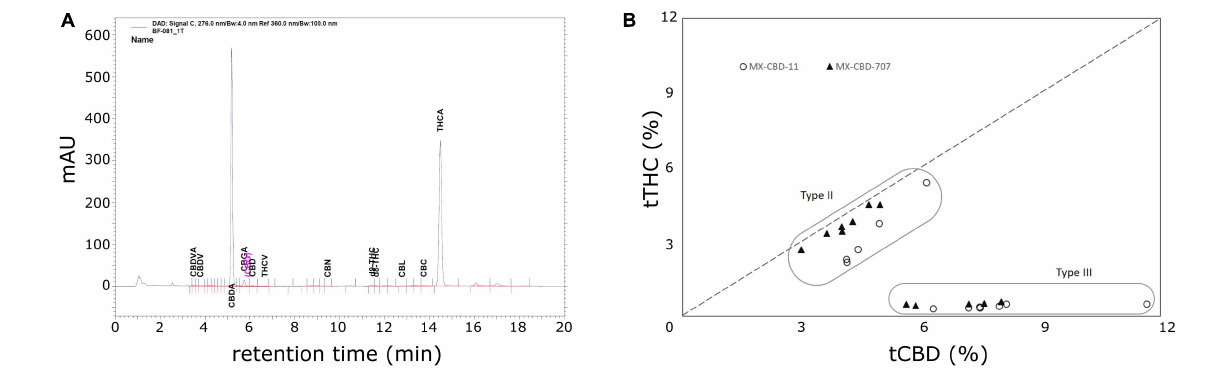
characterised as drug-type cannabis, as none of them